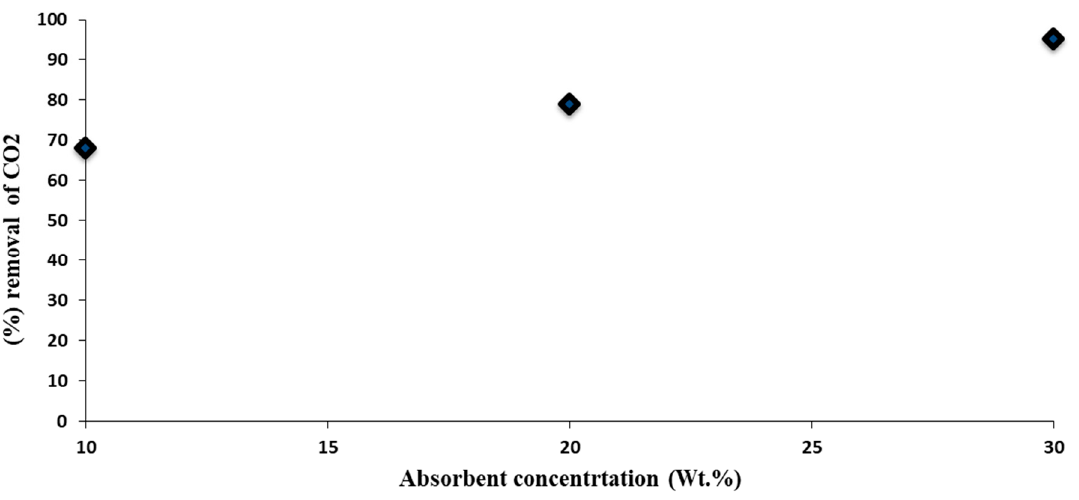
Figure 17. Impacts of absorber’s concentration on the amount of CO 2 removal (d nozzle = 6 mm-Q L = 2.85 × 10 − 4 m 3 /s, pressure outlet = 2000 Pag).